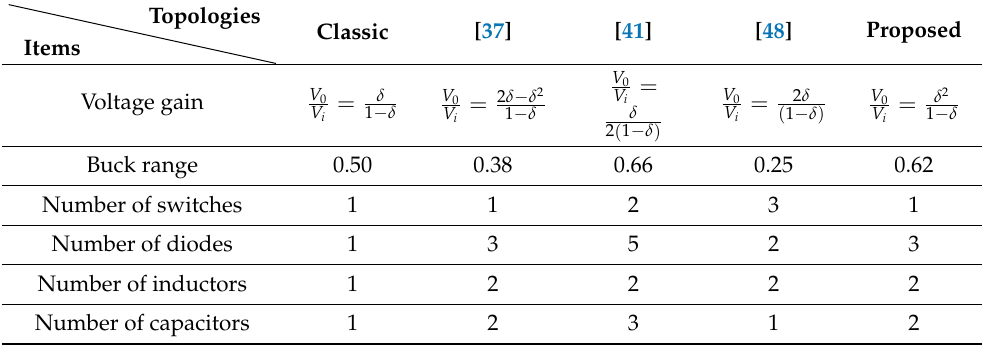
Table 1. Comparison of the proposed solution with other buck-boost topologies presented in the